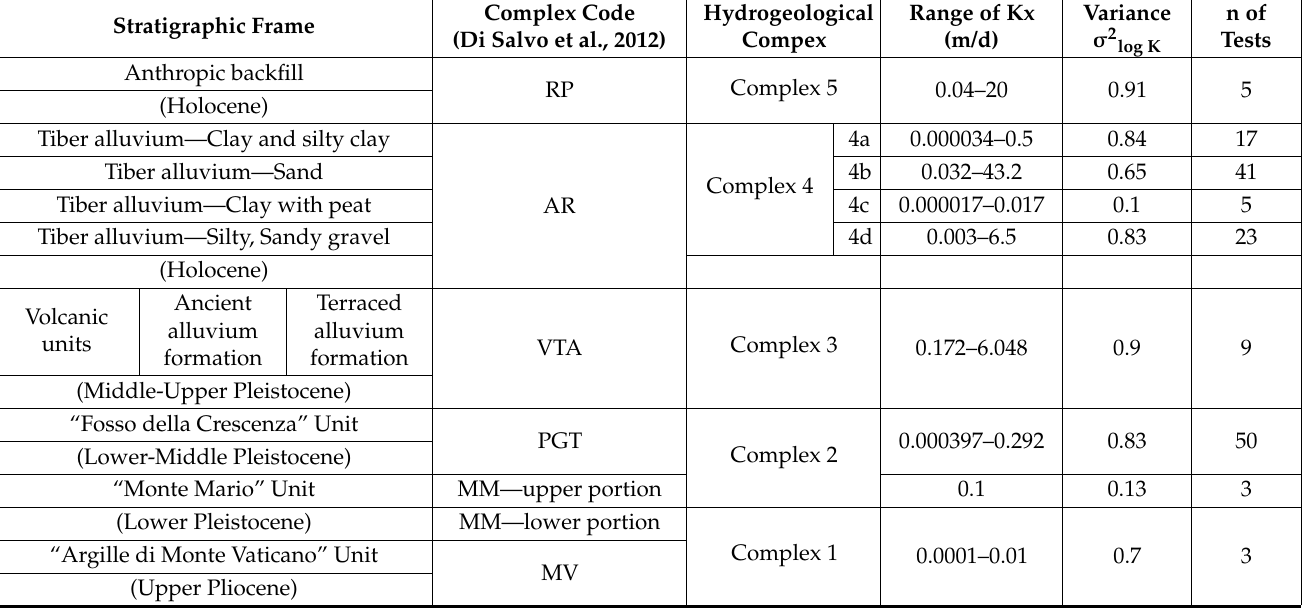
Table 1. Hydrogeological parameterisation of the complexes (from